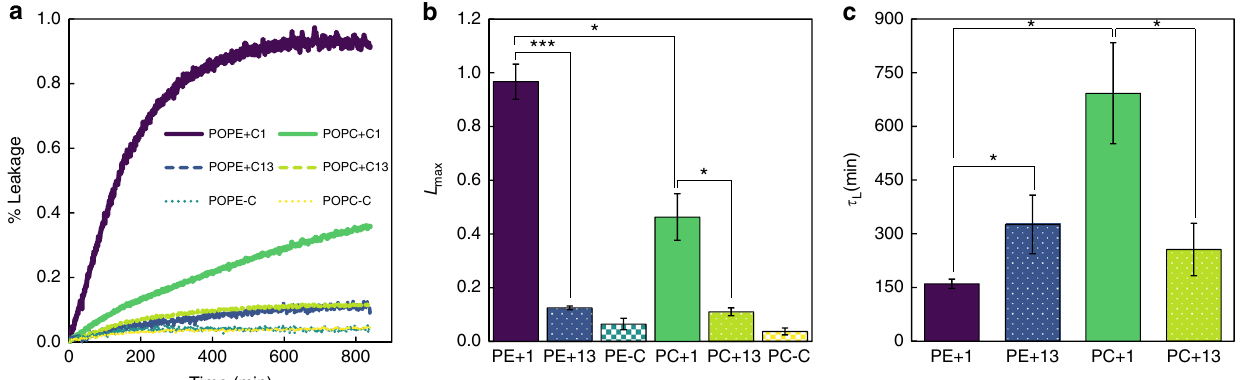
Fig. 7 Membrane permeabilizing activity of 1 and 13 towards POPE vs. POPC membranes. a Representative membrane permeability curves of POPE and POPC LUVs in the absence or presence of compound 1 and 13 at 50 µ M. The leakage of carboxy fl uorescein from LUVs over time, which is a measure of membrane permeability due to the action of 1 and 13 , was obtained through the variation of carboxy fl uorescein fl uorescence intensity at excitation and emission wavelengths of 495 and 535 nm, respectively, according to Equation 1 (see Methods section). The nonlinear fi tting of an exponential law (Equation 2, Methods section) allows to quantitatively describe the maximum extent and kinetics of the process. In b and c the curve fi tting parameters, maximum membrane leakage ( L max ) and c leakage time ( τ L ) are shown as average ± SD of three independent experiments (Student ’ s t -test: * p < 0.05; *** p < 0.001)